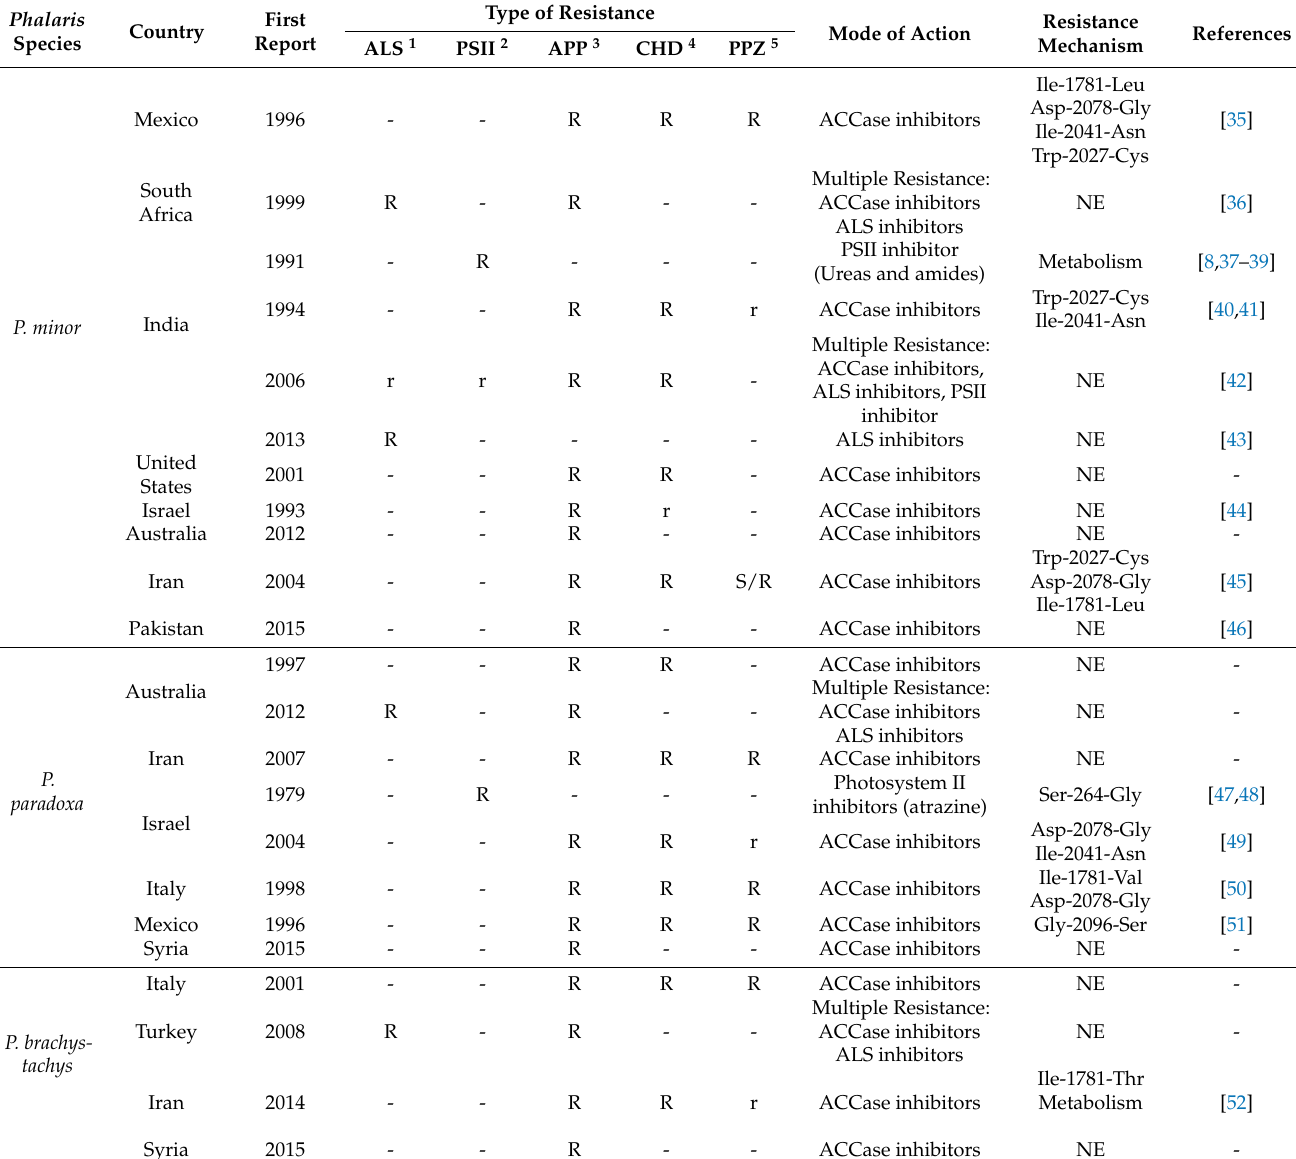
Table 1. Summary of the current worldwide occurrence of Phalaris spp. with resistance mechanisms to different herbicide